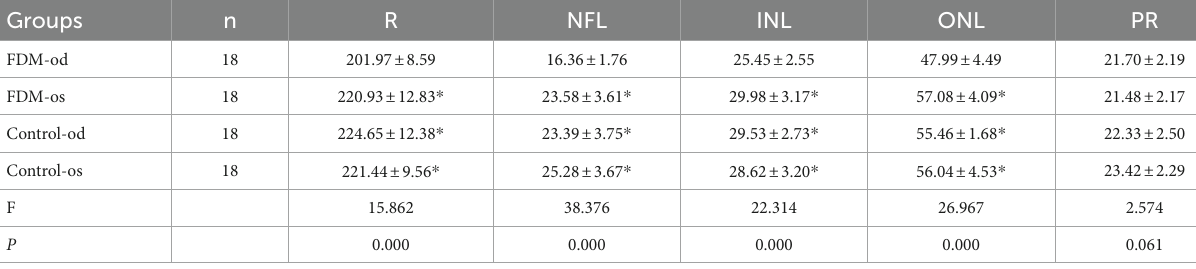
TABLE 2 Thickness of the retina between the FDM and control groups (mean ± s ， μ m). Groups